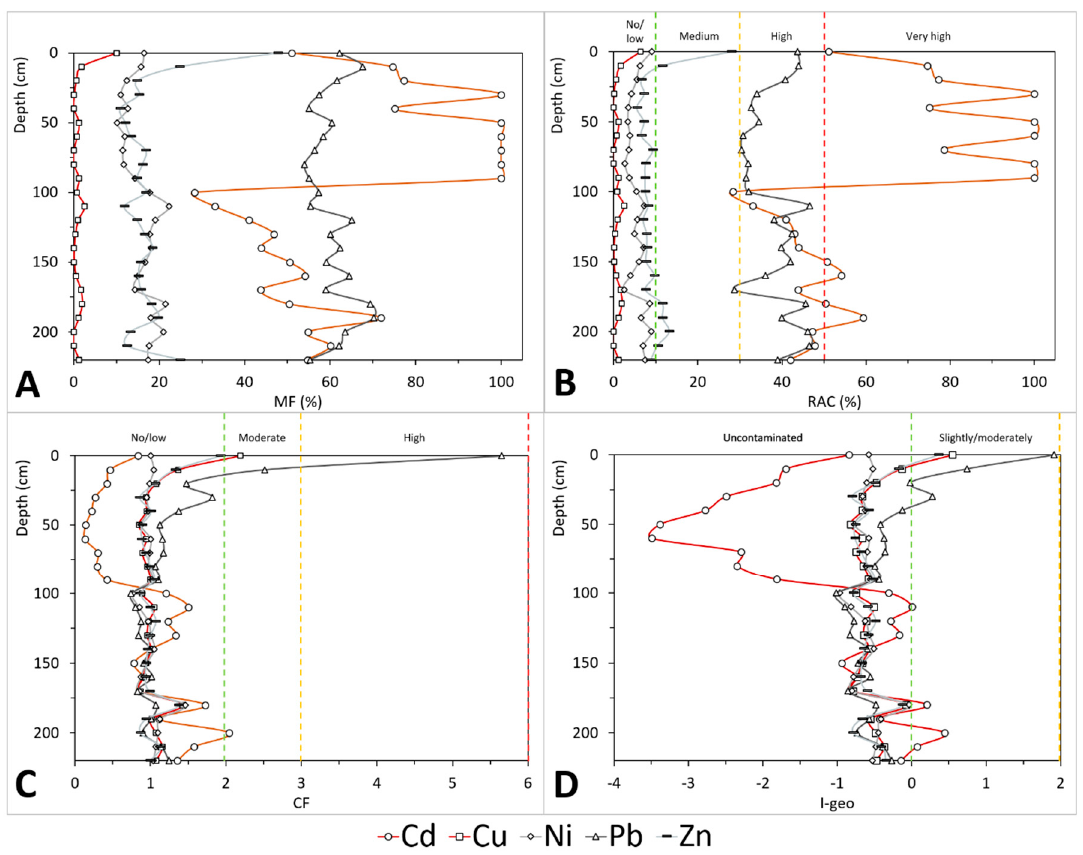
Figure 3. Vertical distribution of the tested indices for the studied metals (Cd, Cu, Ni, Pb, and Zn) in the sediments of San Simon Bay. ( A ) Mobility Factor; ( B ) Risk Assessment Code; ( C ) Contamination Factor; ( D ) Geoaccumulation Index. Vertical broken lines in B, C, and D represent the thresholds used in the assessment of each index.